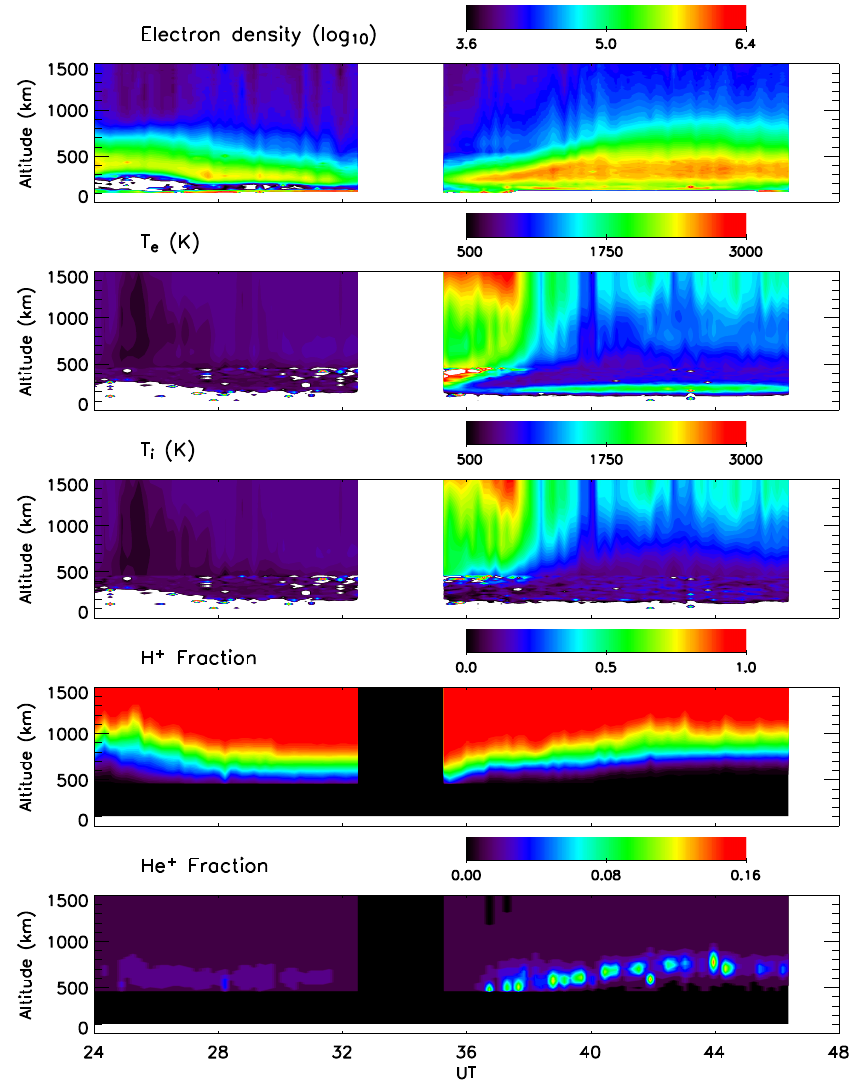
Fig. 7. Summary Jicamarca data for the full profile analysis. From top to bottom, the panels represent electron density, electron temperature, ion temperature, hydrogen ion fraction, and helium ion fraction (18% full scale). A data gap exists when the galaxy was directly over the radar.